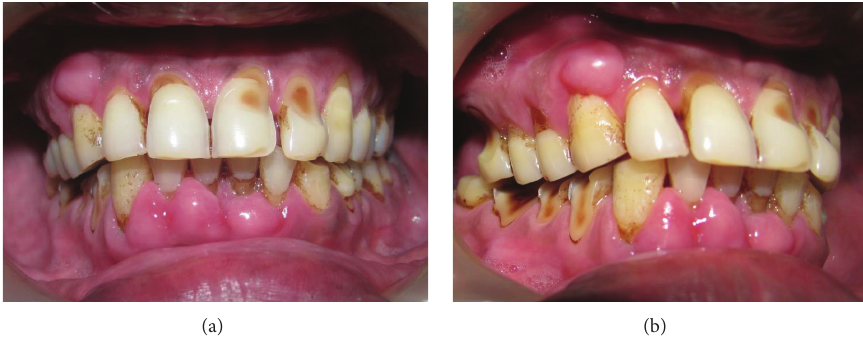
Figure 1: (a) Preoperative view. (b) Preoperative